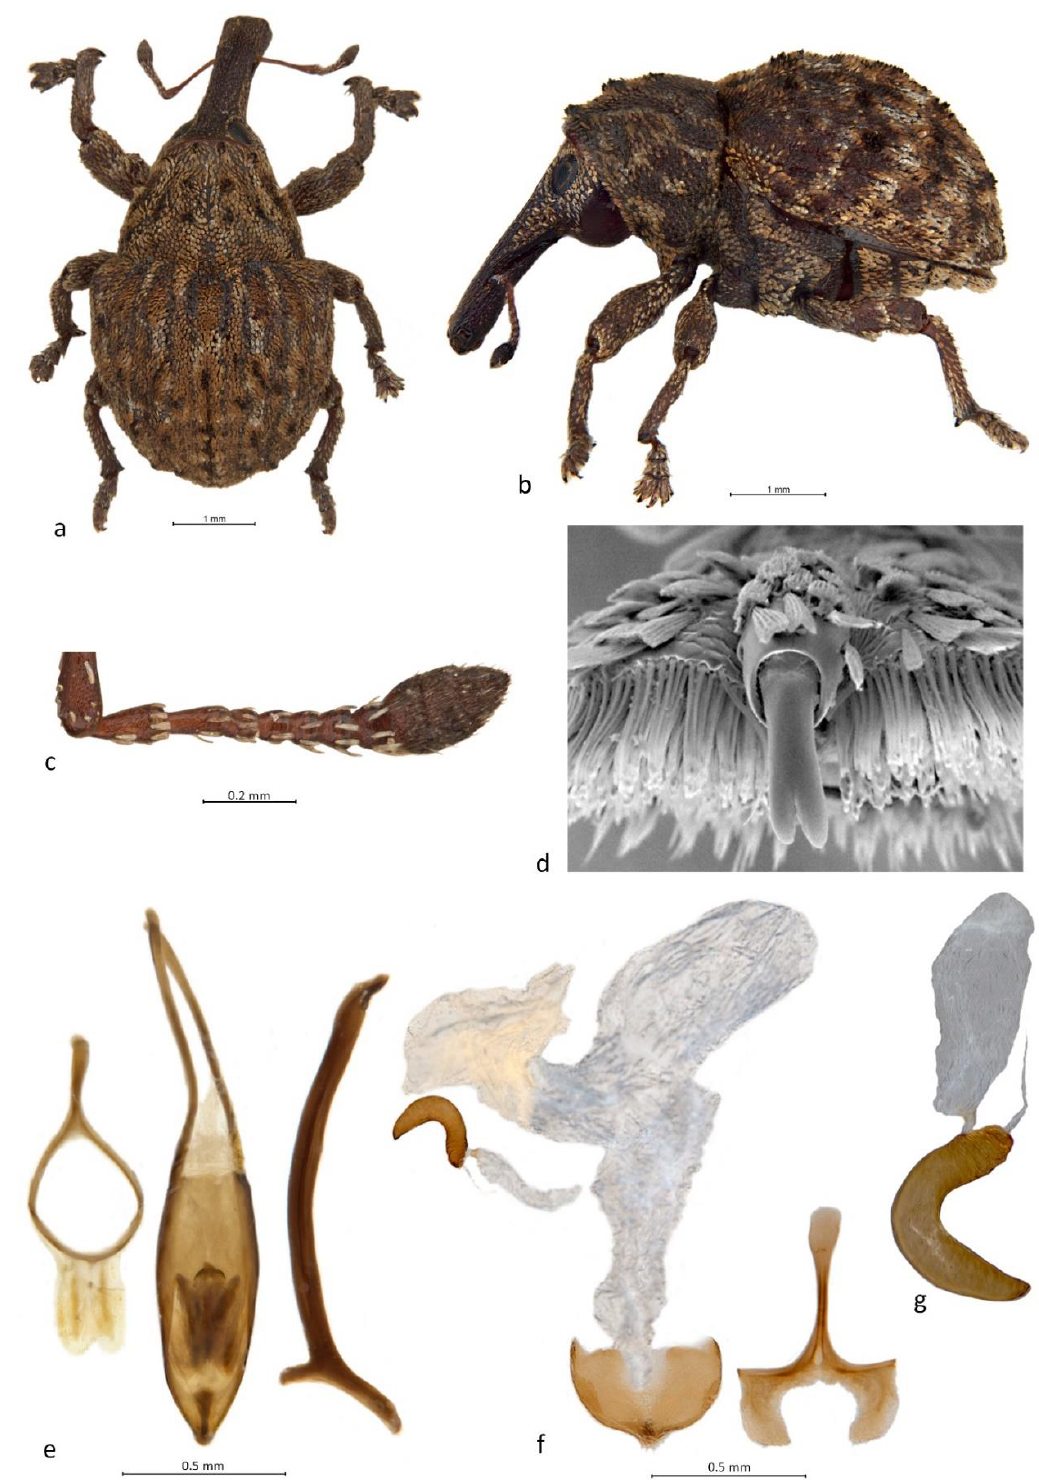
Figure 3. Habitus and diagnostic characters of Haplonyx Schoenherr ( H. casuarinae (Lea)): ( a ) habitus of male, dorsal view; ( b ) habitus of male, left lateral view; ( c ) right antenna, male, dorsal view; ( d ) tarsite 3 with onychium, apical view; ( e ) genitalia, male, dorsal view; ( f ) genitalia, female, dorsal view; ( g ) spermatheca with gland.